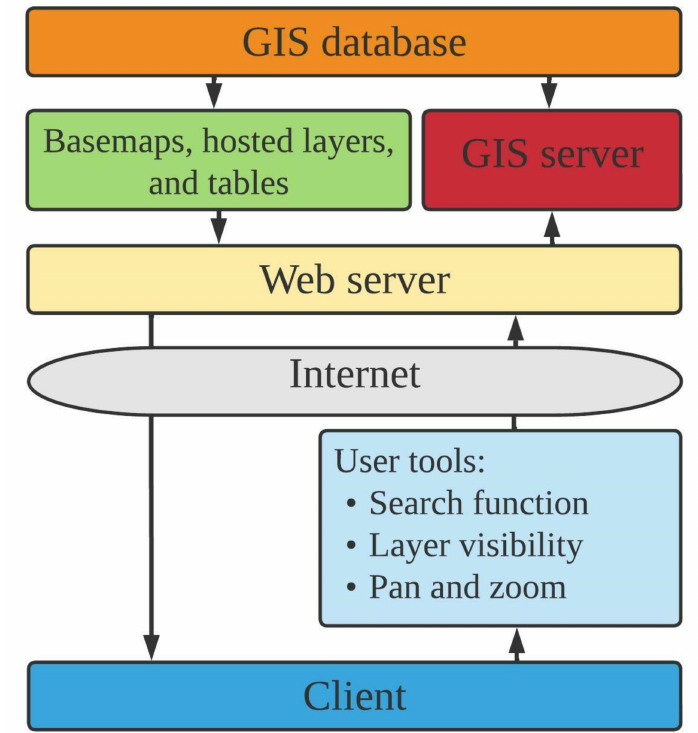
Figure 4. The system architecture of the web